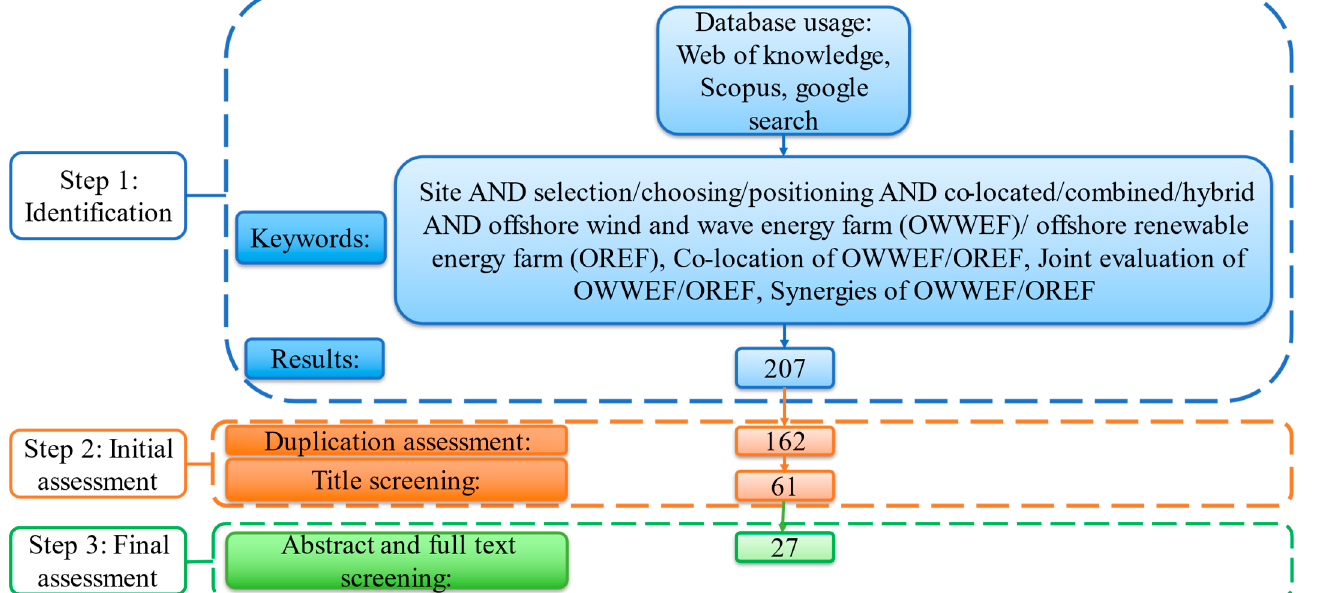
Figure 1. Flowchart for selection of existing studies based on systematic literature review guidelines.